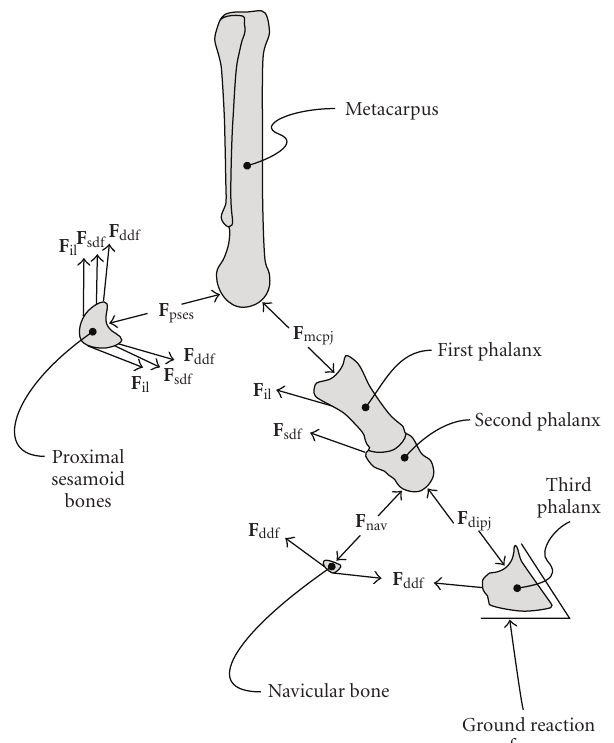
Figure 3: Forces considered when calculating the joint reaction forces at the fetlock and co ffi n joints. The forces were the ground reaction force, the force exerted by the distal phalanx on the middle phalanx ( F dipj ), the force exerted by the navicular bone on the middle phalanx ( F nav ), the DDFT force ( F ddf ), the SDFT force ( F sdf ), the IL force ( F il ), the force exerted by the proximal phalanx on the distal metacarpus ( F mcpj ), and the force exerted by the proximal sesamoid bones on the distal metacarpus ( F pses